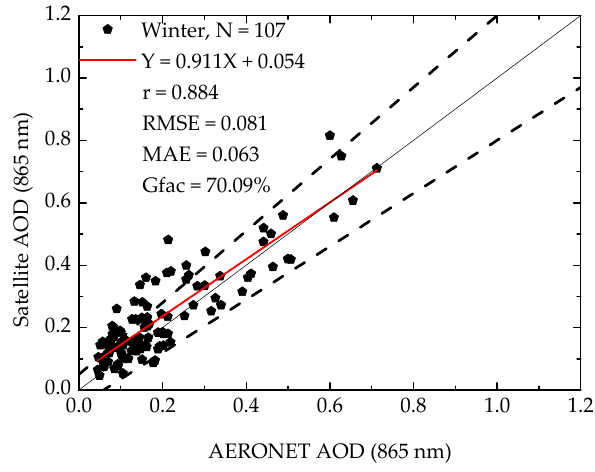
Remote Sens. 2017 , 9 , 578